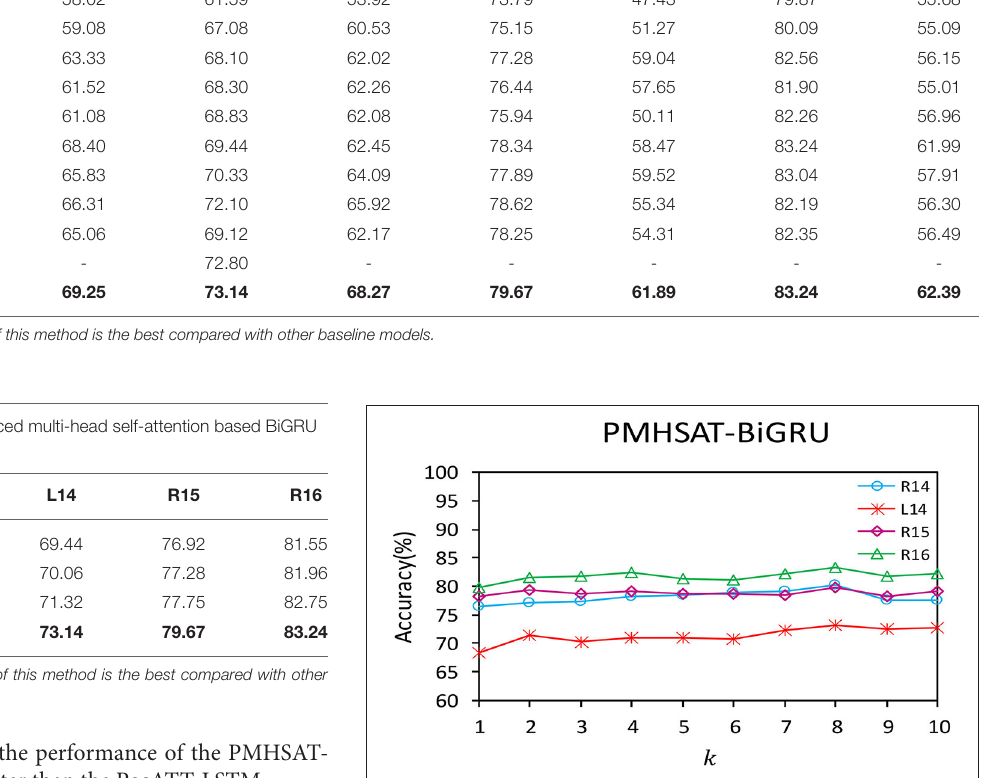
FIGURE 2 | The influence of the number of the heads k of the multi-head attention mechanism on the accuracy of the